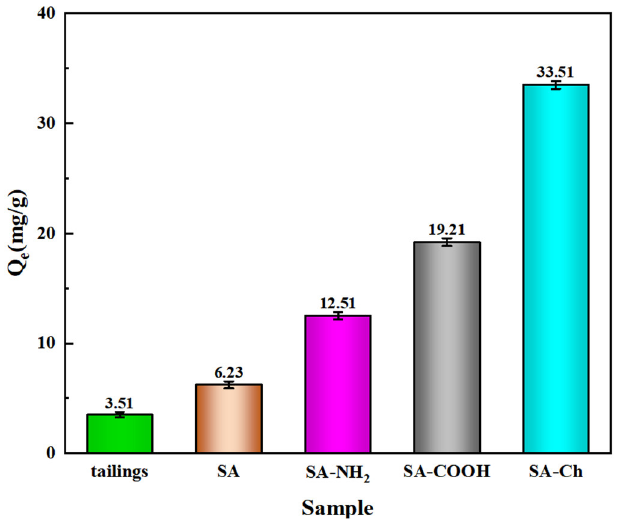
Figure 10. Adsorption capacity of Cu 2+ by the tailings, SA, SA-NH 2 , SA-COOH, and SA-Ch.